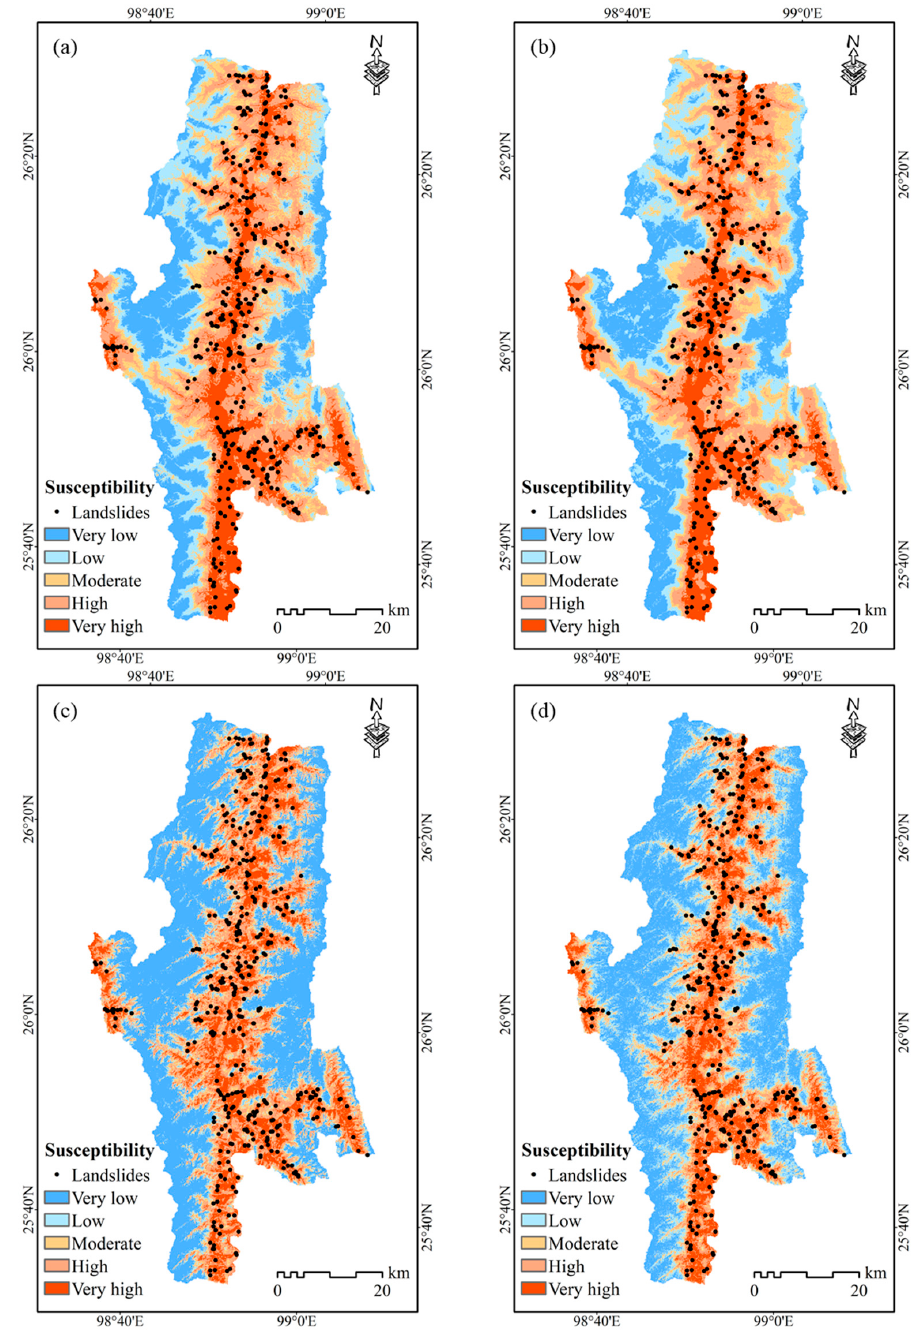
Figure 7. Landslide susceptibility mapping using ( a ) ADAANN, ( b ) DNN, ( c ) CNN, ( d ) DRNN.